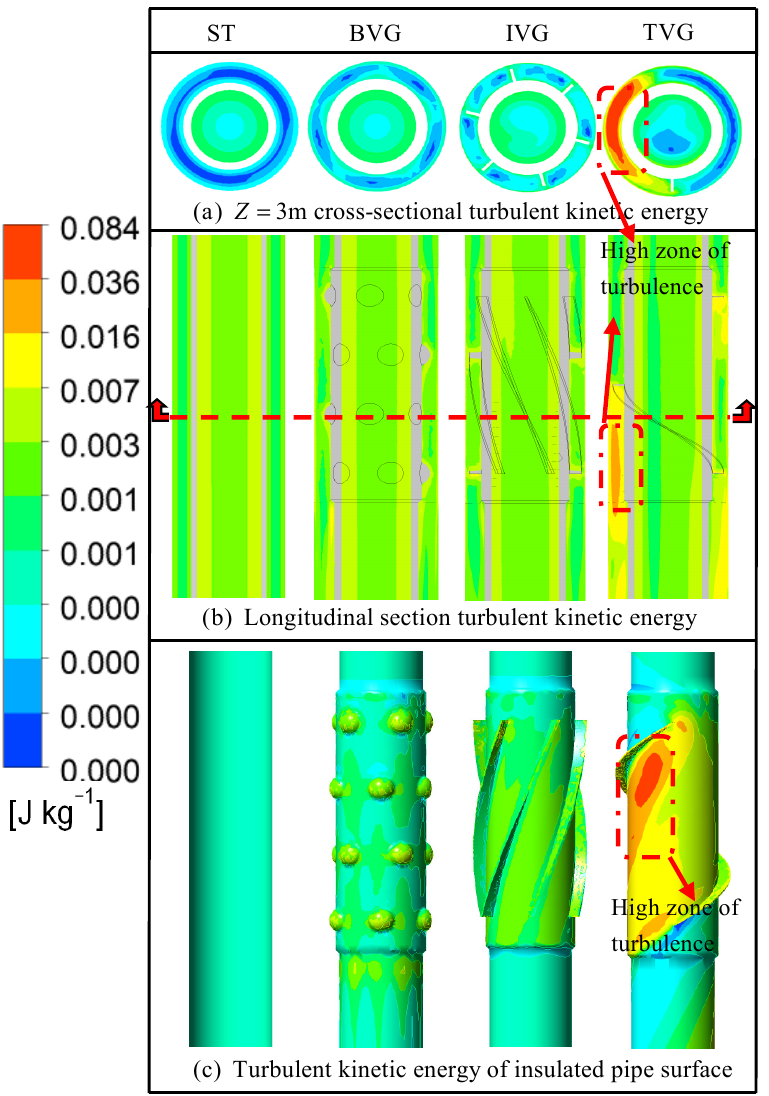
Figure 6. Distributions of the turbulent kinetic energy in the vortex generator area of the four heat Figure 6. exchangers.